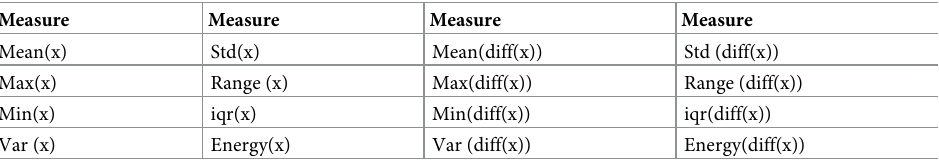
Table 1. Measures applied to create